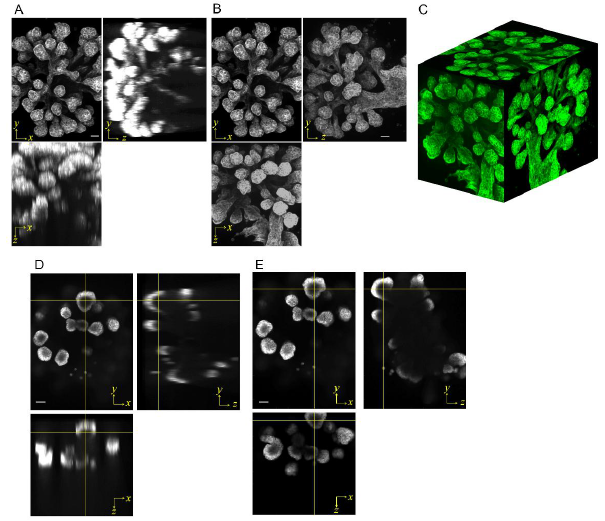
Figure 3. Comparison of projected and section images of a developed bronchial tree in a gel cube taken from a single ordinal side and from six sides. Actin filaments were stained. The objective lens used had 10× magnification (NA 0.45), and the scanning area was 1087 × 1450 × 1087 µm. ( A ) Images of scanning z -stack data projected from one side to the x-y , y-z and z-x planes. Most undetected